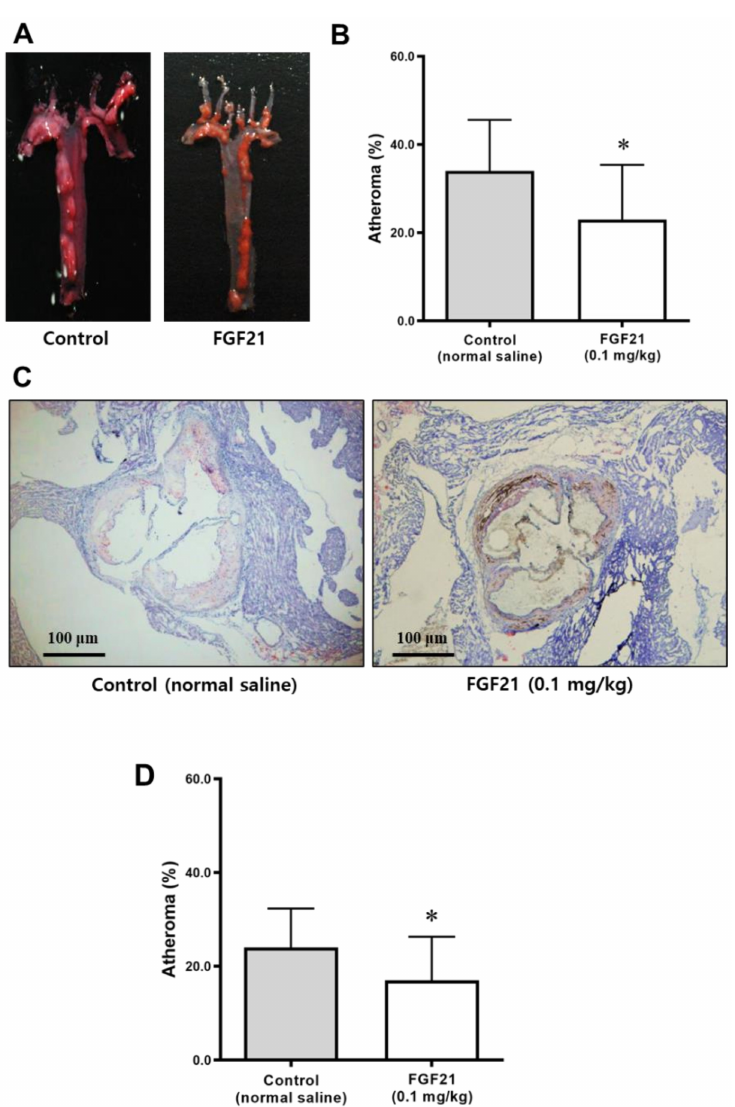
Figure 4. Atheroma burden in the aorta of ApoE − / − mice after 5 weeks of treatment with FGF21 or normal saline. ( A , C ) Representative images of atheroma stained using Oil Red O of the aortic arch ( A ) and aortic valve areas (scale bars, 100 µ m) ( C ) from ApoE − / − mice. The red color indicates plaque accumulation. ( B , D ) The atheromatous plaque area (% of total area) was smaller in the aortic arch ( B ) and aortic valve ( D ) of the FGF21-treated mice compared with the control. Data are means ± SD. Weight-adjusted comparison was used. * p < 0.05 vs.